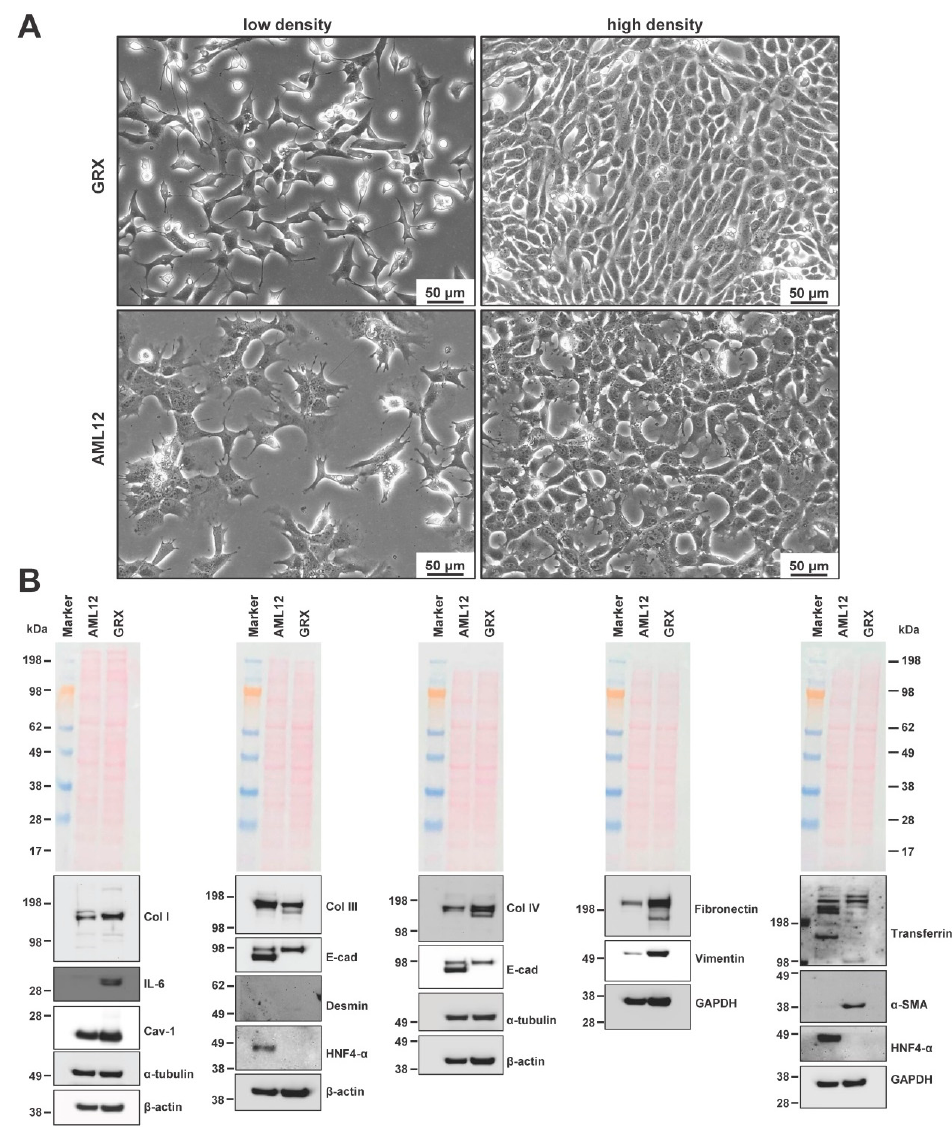
Figure 2. Phenotypic characteristics of GRX cells. ( A ) GRX and AML12 cells were seeded in cell culture dishes and representative images taken from subconfluent and confluent cultures. Original magnifications are 200 × . The space bars correspond to 50 µ m. ( B ) Cell extracts were prepared from AML12 and GRX cells and analyzed for expression of α -smooth muscle actin ( α -SMA), caveolin-1 (Cav-1), collagen type I (Col I), collagen type III (Col III), collagen type IV (Col IV), desmin, E-cadherin (E-cad), and fibronectin, hepatocyte nuclear factor 4 (HNF4- α ), interleukin 6 (IL-6), transferrin, and vimentin. The expression of α -tubulin, β -actin, or GAPDH and the Ponceau S stain were included to demonstrate equal protein